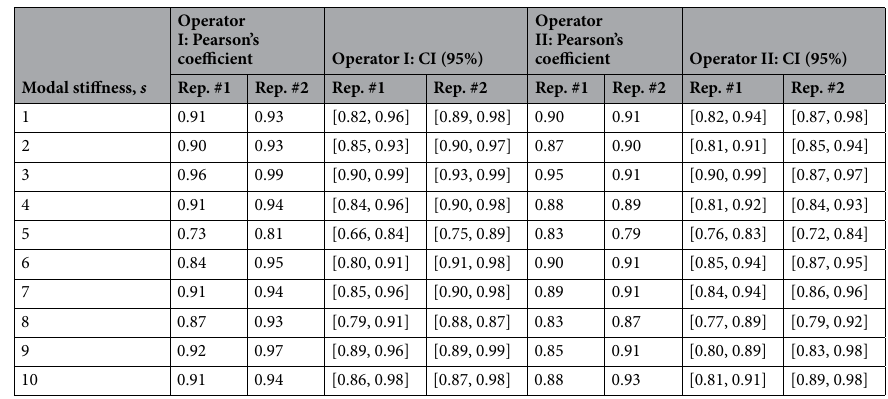
Table 5. Correlation metrics between modal stiffness computed on model FEMP-II with automatically and manually marked boundary